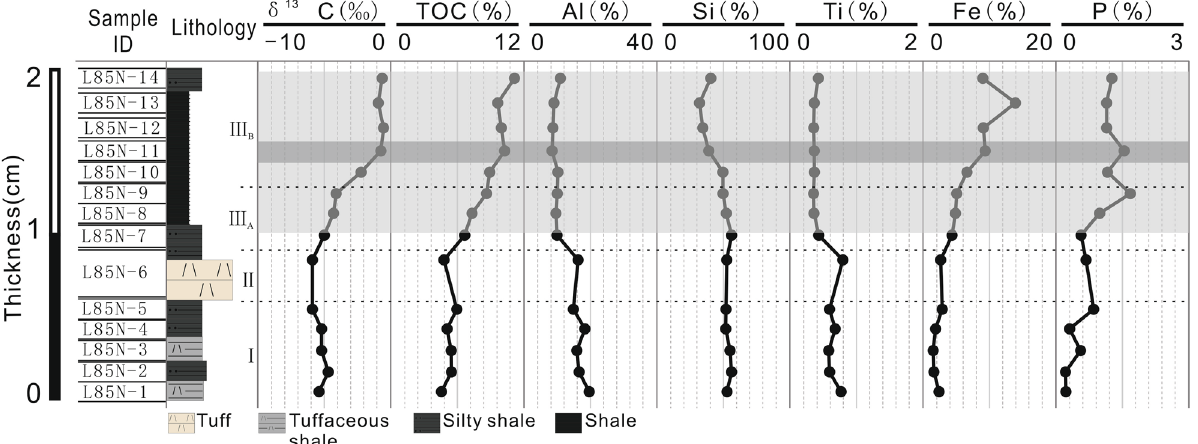
Figure 4. Carbon geochemical data (δ 13 C, total organic carbon (TOC)), major terrigenous elements (Si, Al, and Ti), biolimiting elements (Fe and P), and lithology for 14 samples. Enrichments in TOC are in gray; Si, Al, Ti, Fe, and P contents are in weight percentage.